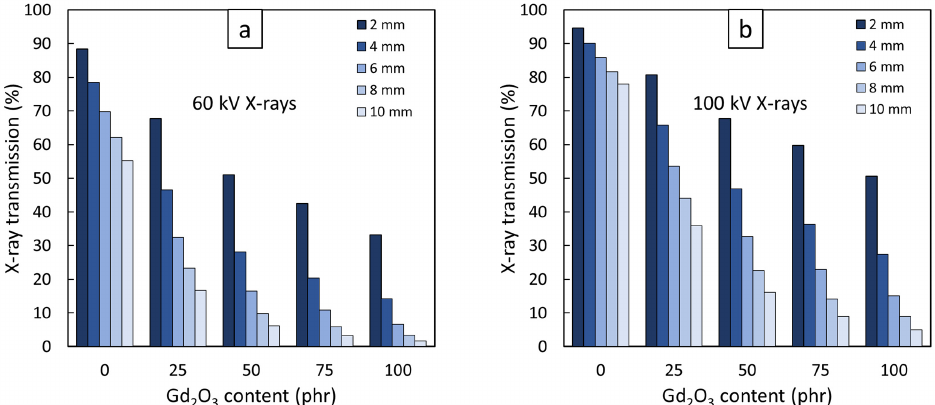
Figure 6. X-ray transmission of Gd 2 O 3 /NR composites with varying thicknesses from 2 to 10 mm and varying Gd 2 O 3 contents from 0 to 100 phr determined at X-ray supplied voltages of ( a ) 60 kV and ( b ) 100 kV.